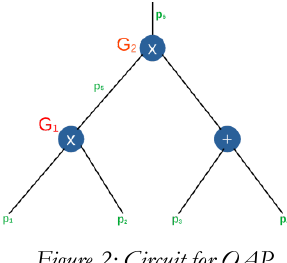
Figure 2: Circuit for